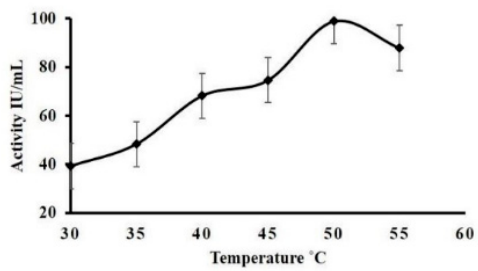
Figure 6. Effect of fermentation temperature on endopolygalacturonase production.